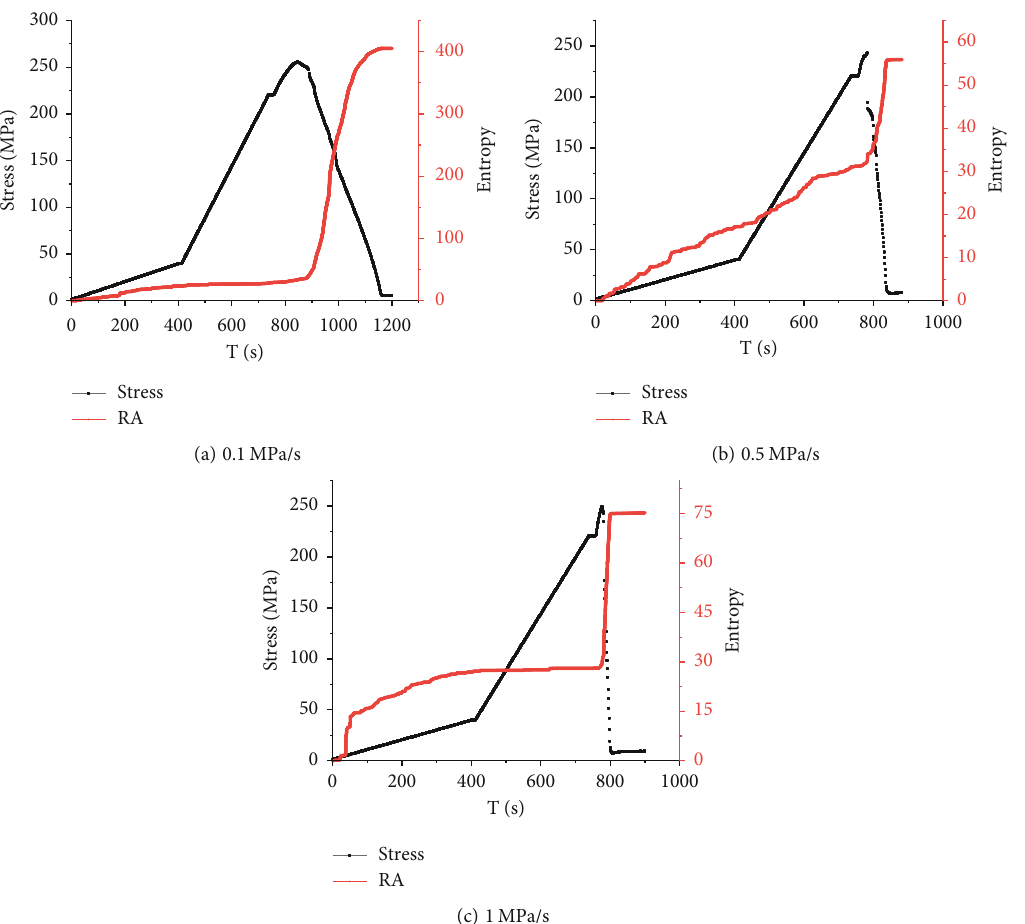
Figure 6: Limestone time-stress-entropy relationship curve under the same con fi ning pressure (40 MPa) and di ff erent unloading